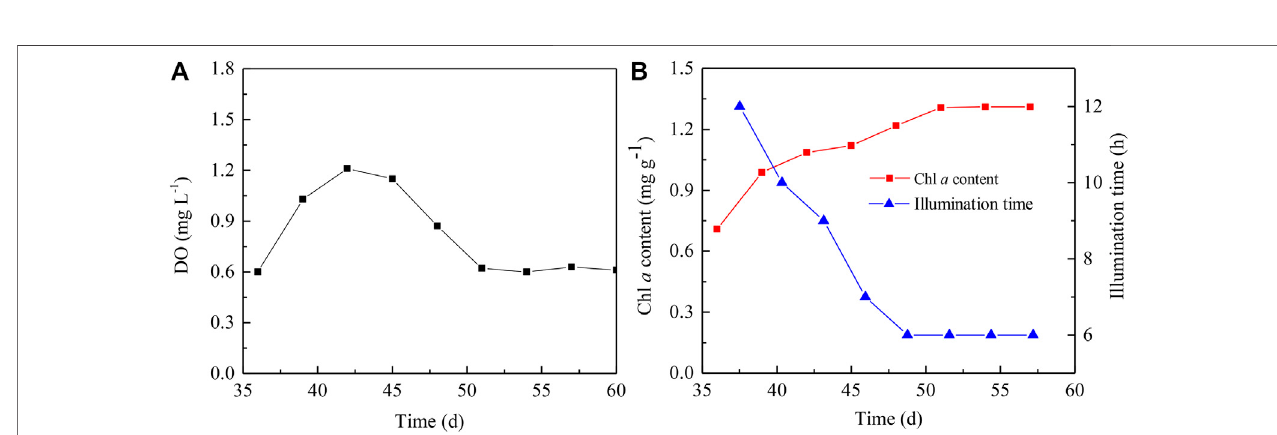
FIGURE 3 | Changes in the DO level (A) and Chl a content and illumination time (B) in microalgae-intensi fi ed PN reactor.